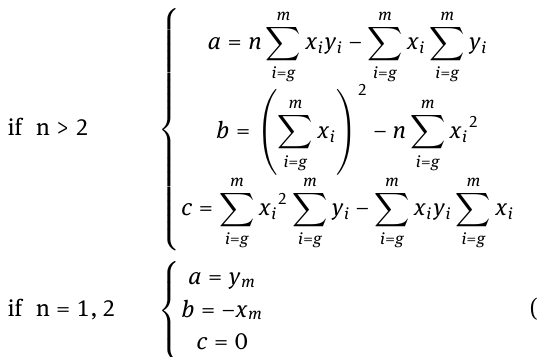
Fig. 11. Calculation of Position and Direction of Foot in "Fuzzy" Situa- tion